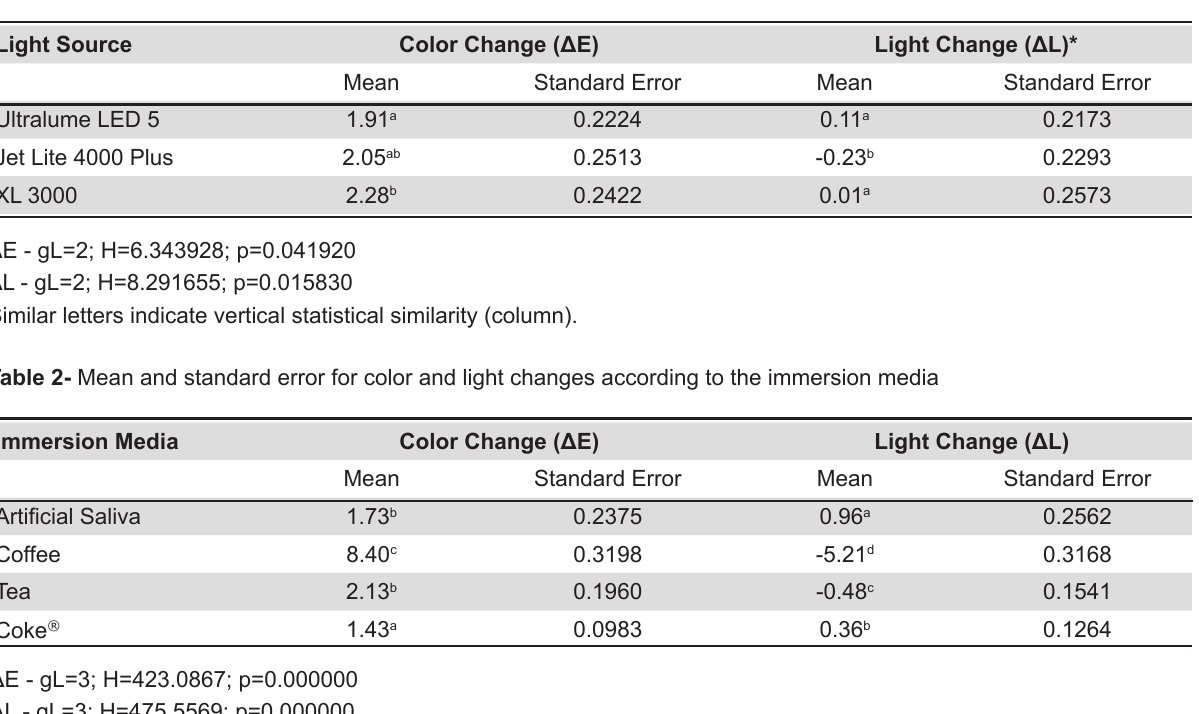
Table 1- Mean and standard error for color and light changes depending on the light sources